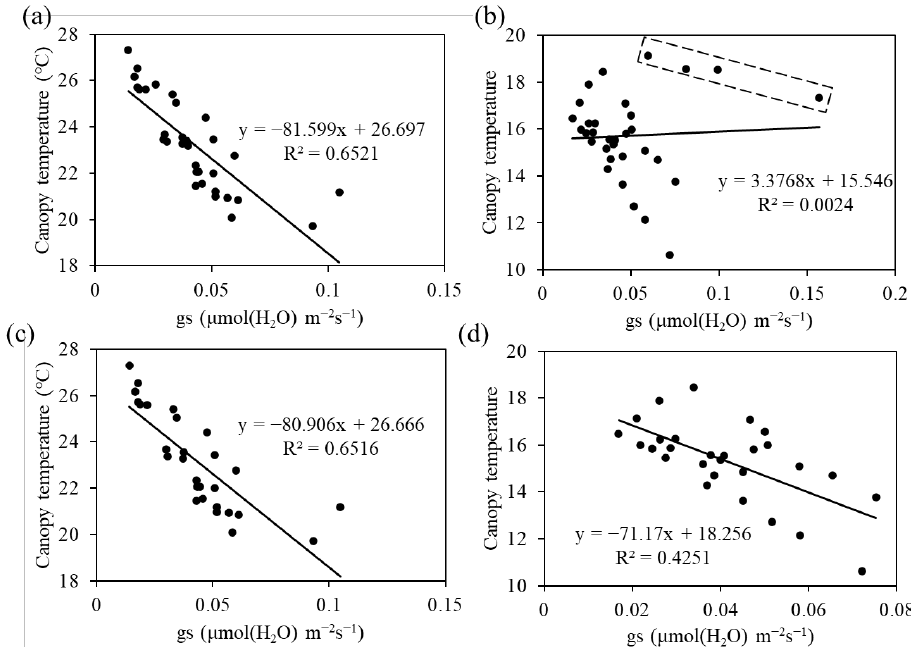
Figure 5. Regression analysis between canopy temperature and stomatal conductance (gs); ( a ) control and inoculation treatments on the 44th and ( b ) 57th days; and control and inoculation treatments without AMF treatment on ( c ) the 44th day and ( d ) the 57th day. The points in the dotted box in the Figure are AMF treatment data.